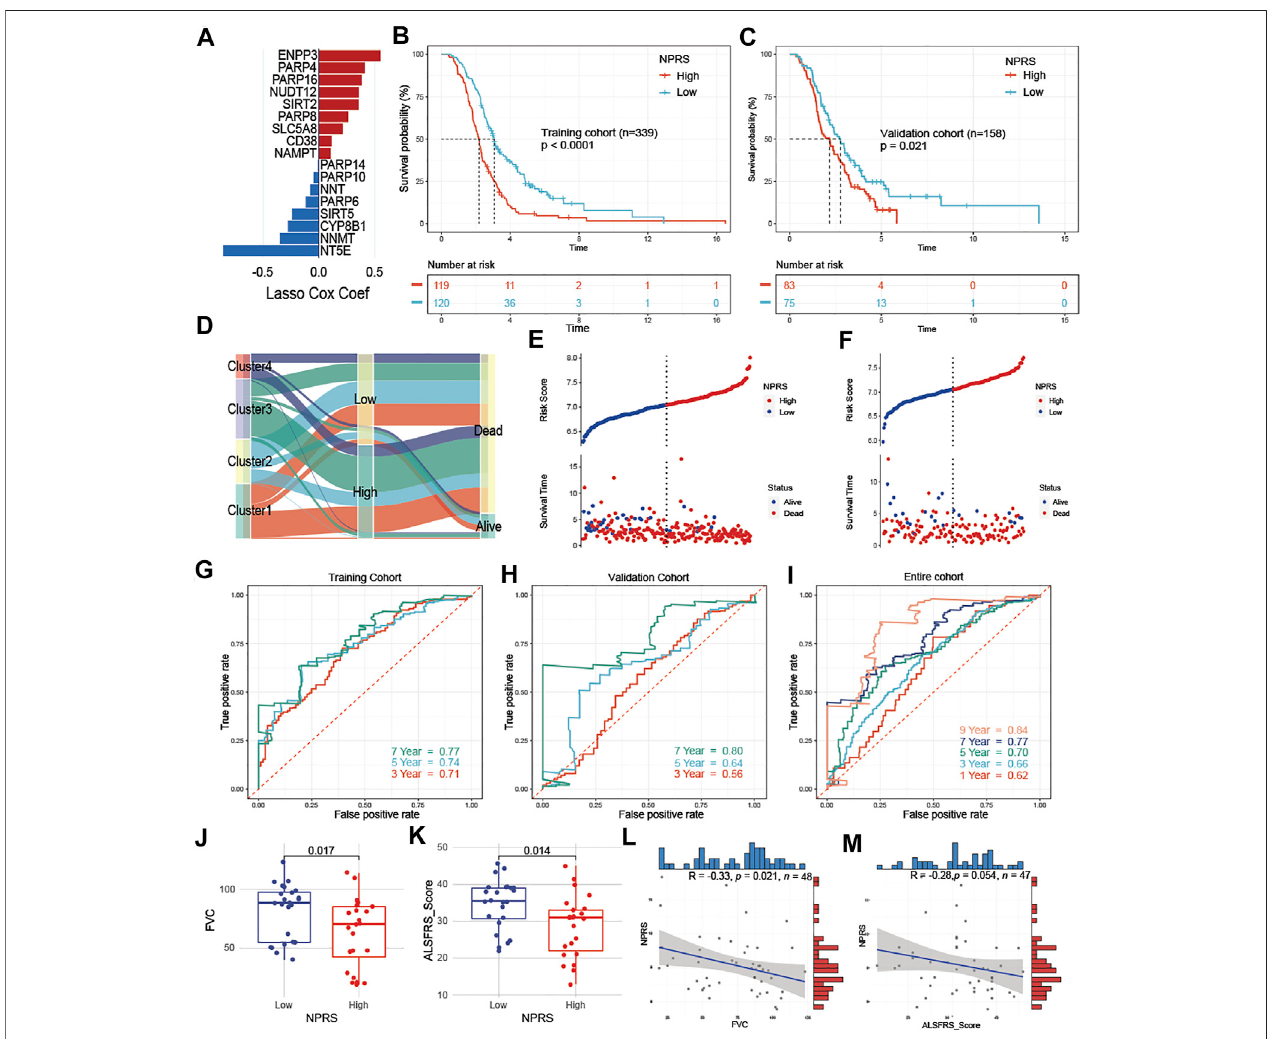
FIGURE 5 | Development and assessment of a prognostic NAD+ metabolism-related signature for ALS patients (A) An ensemble of 17 genes remained with individual coef fi cients (B) and (C) Kaplan-Meier survival analysis for patients with high- and low- NPRS in the training (B) and validation cohorts (C), ALS patients in the high group had worse prognostic survival than those in the low group (D) Sankey plot of four clusters distribution in groups with different NPRS, and survival outcomes (E) and (F) Riskplotsshowed thatpatients withlowscoresinthetraining(E) andvalidationcohorts(F)had bettersurvival (G – I) Inthetraining(G),validation (H),and entire (I) cohorts, time-dependent receiver operating characteristic analysis showed NPRS had better performance in predicting the survival of ALS patients (J) and (K) Patients in the low NPRS group had better FVC (J) and ALSFRS (K) scores compared to the high NPRS group in E-TABM-940 (L) and (M) In E-TABM-940, NPRS was negatively correlated with FVC (L) or ALSFRS (M) scores,